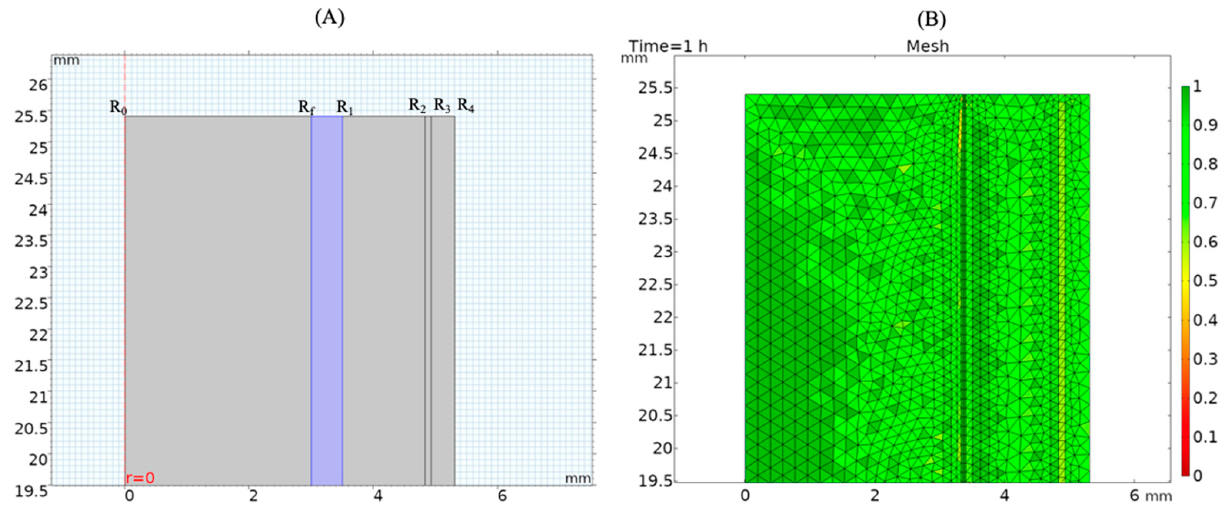
Figure 2. ( A ) Model geometry highlighting different layers: fouling (R f –R 1 ), product (R 0 –R f ), stainless steel pipe wall (R 1 –R 2 ), air gap (R 2 –R 3 ), and sensor (R 3 –R 4 ); and ( B ) Model mesh quality (skewness) evaluation.